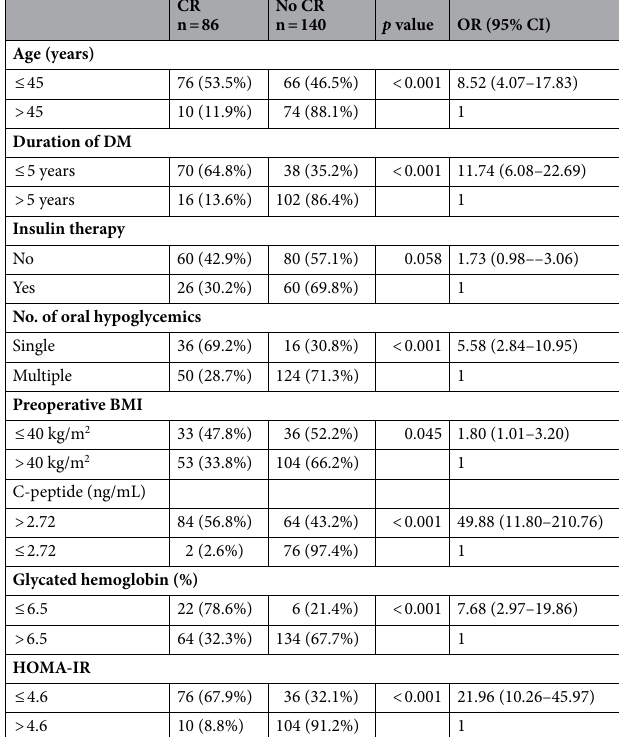
B p value OR (95% CI)